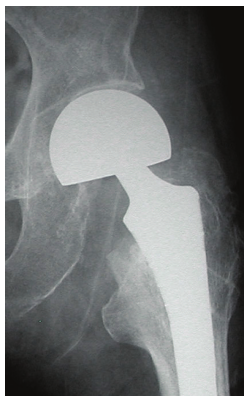
Figure 2: The outer head is set adequately in the acetabulum.